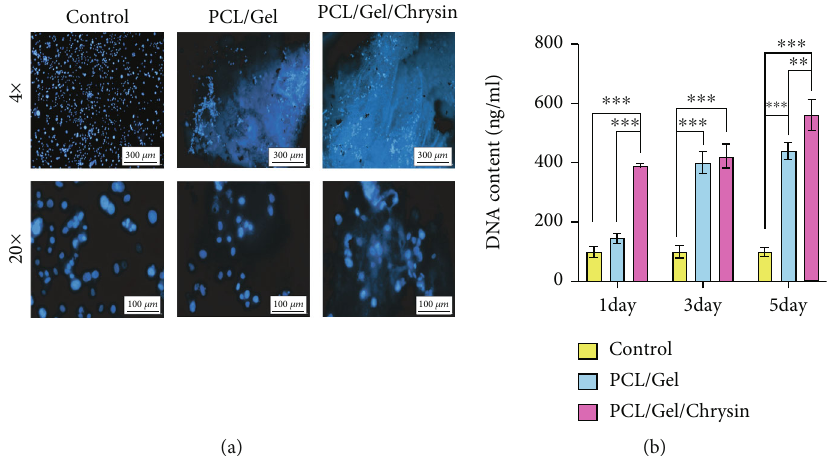
Figure 6: (a) The cell viability of the DPSCs by DAPI staining in control, PCL/Gel, and PCL/Gel/Chyrsin groups for 5 days. (b) The DNA content extracted from DPSCs grown into control, PCL/Gel, and PCL/Gel/Chrysin on days 1, 3, and